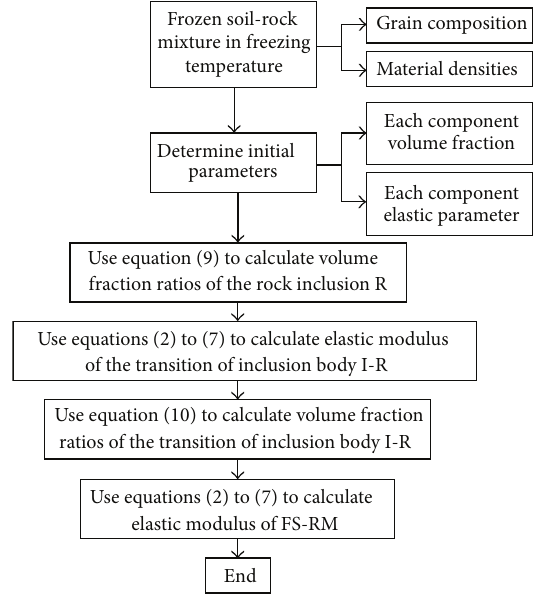
Figure 8: Flowchart of the calculation of the elastic modulus of frozen soil-rock